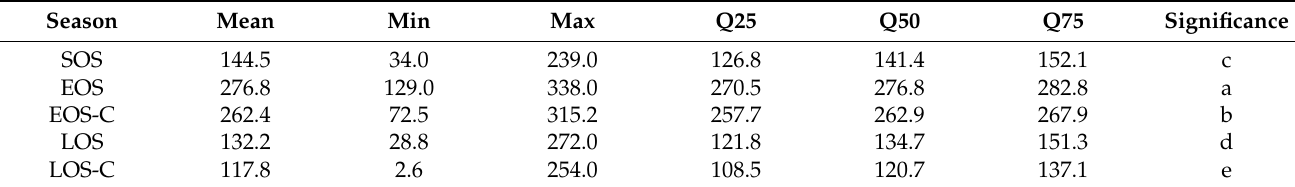
Table 3. Summary statistics and the least significant difference test results for the onset and length of the cropland growing season in Northeast China from 2001 to 2010 as influenced by calibration. EOS-C, calibrated end-of-season onset; LOS-C, calibrated length of the growing season.